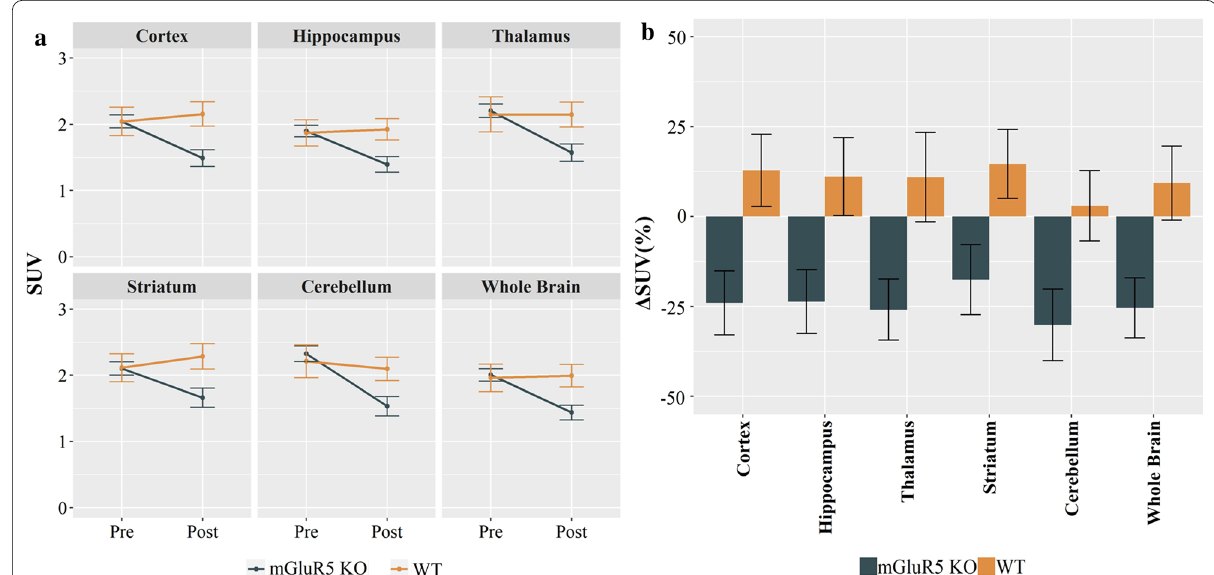
Fig. 1 The mean [ 18 F]FDG PET SUV and ΔSUV with standard error bars in mGluR5 KO and WT mice. a Significantly decreased SUVs were observed in mGluR5 KO mice after the acute administration of MK‑801 ( p < 0.05), whereas no significant alterations were observed in WT mice ( p > 0.05). b The ΔSUV values were significantly different between mGluR5 KO and WT mice in ROIs ( p < 0.05). SUV, standardized uptake value; ΔSUV, the percent change of SUV; ROI, region of